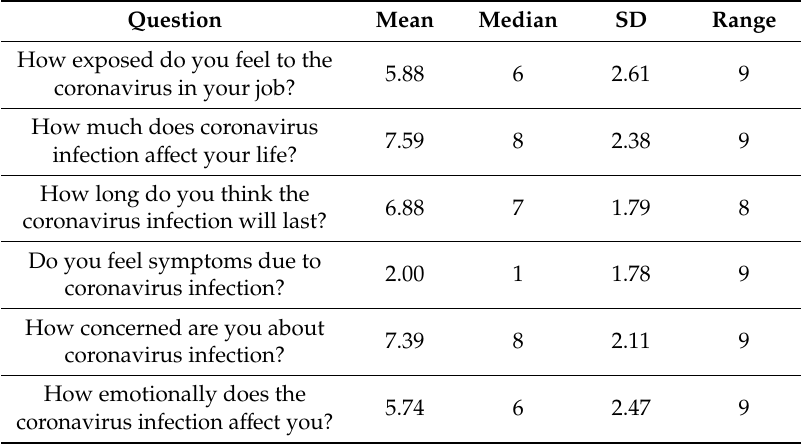
Table 2. Airport workers’ perception of risk regarding